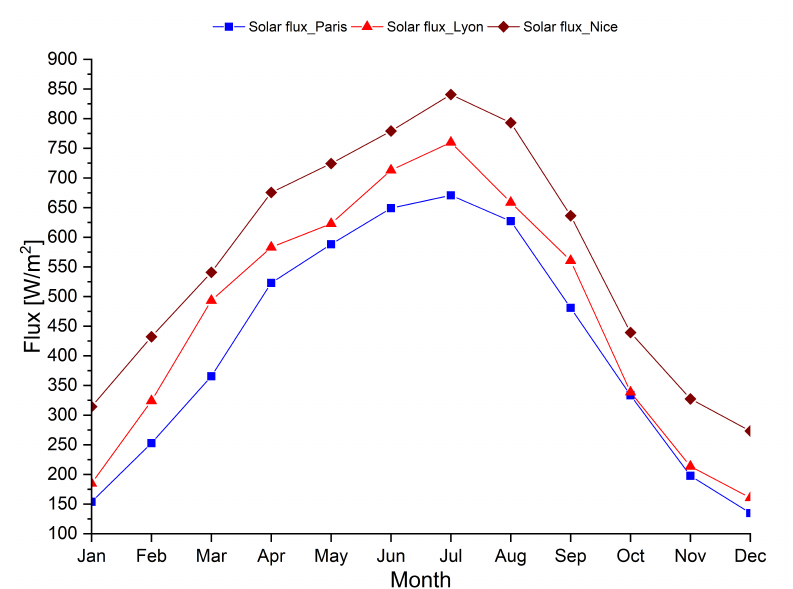
Figure 4. Monthly maximum horizontal global solar fluxes for the weather of Paris-Orly, Lyon, and Nice.